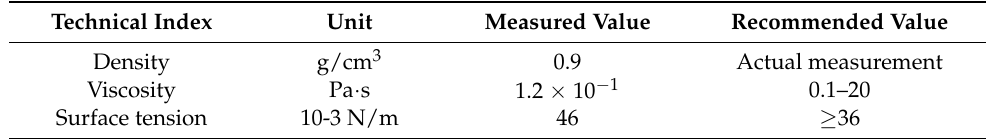
Table 1. Performance index of waste vegetable